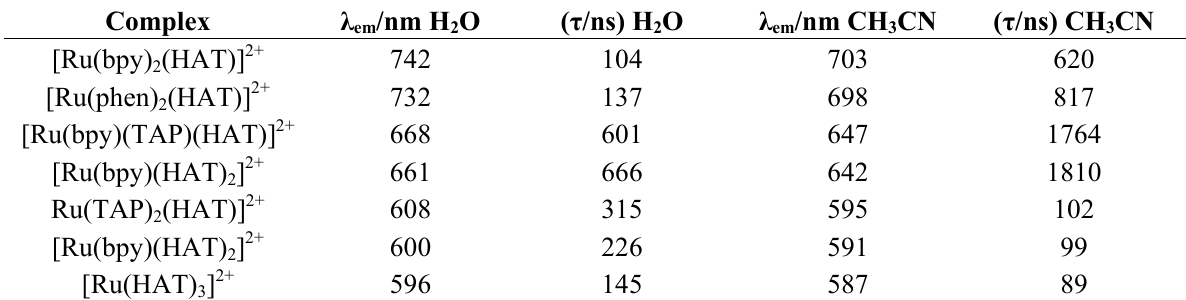
Table 5. Photophysical properties of a series of HAT complexes [150].